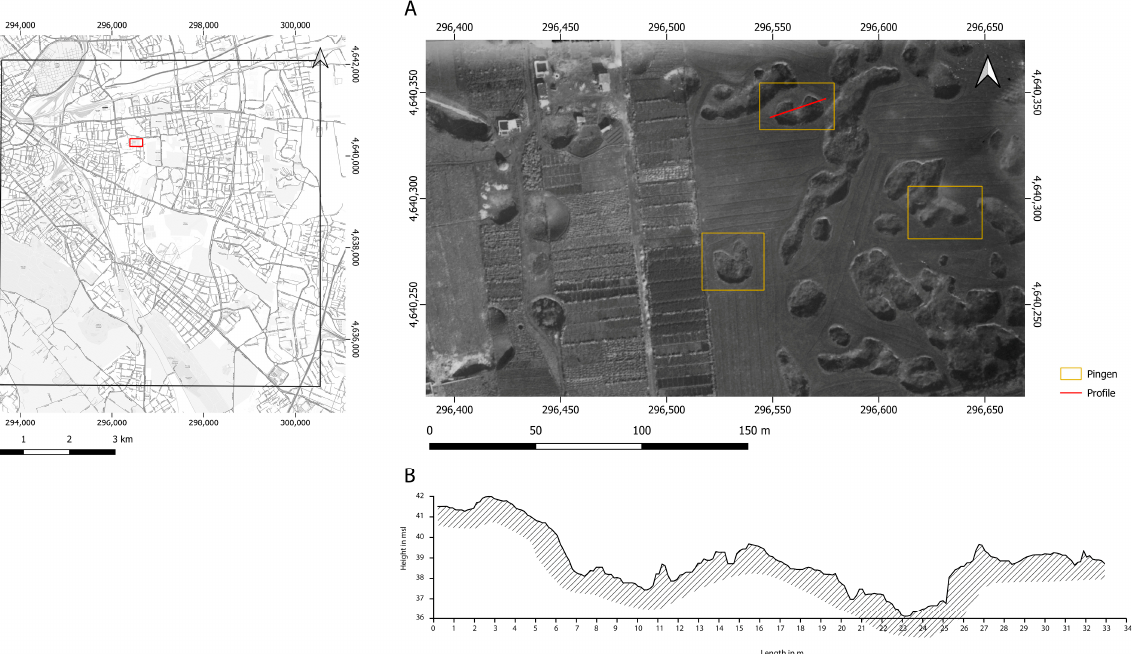
Figure 10. ( A ) Examples of heart-shaped and horn-shaped cave-in forms in the orthorectified photograms. ( B ) profile extraction of a heart-shaped pinge , visible in the plot below the figure. On the left side, the localization of the structures within the AOI border (red polygon). Photograph SARA_1927 from © ICCD-Aerofototeca Nazionale, Fondo SARA, flight 1927.